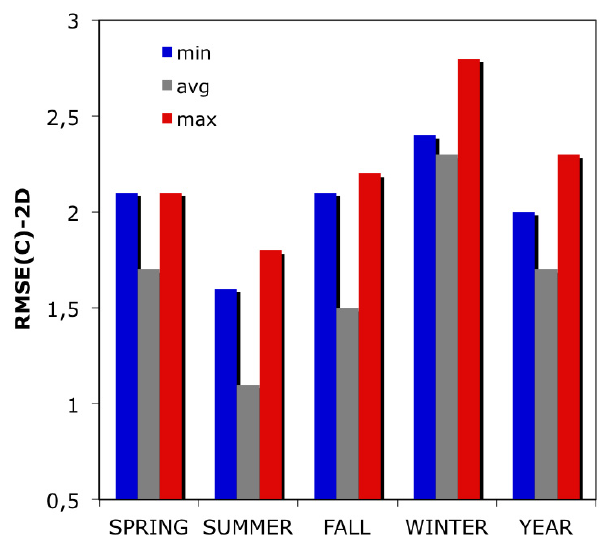
Figure 2. RMSE ( ◦ C) seasonal distribution for minimum (min), mean (avg), and maximum (max) temperature.